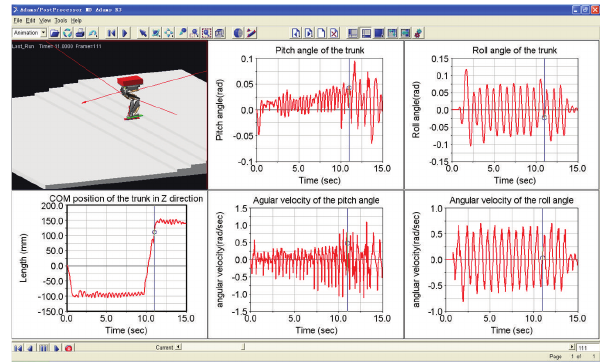
Figure 9: Walking with the balance control method on uneven ter- rain.